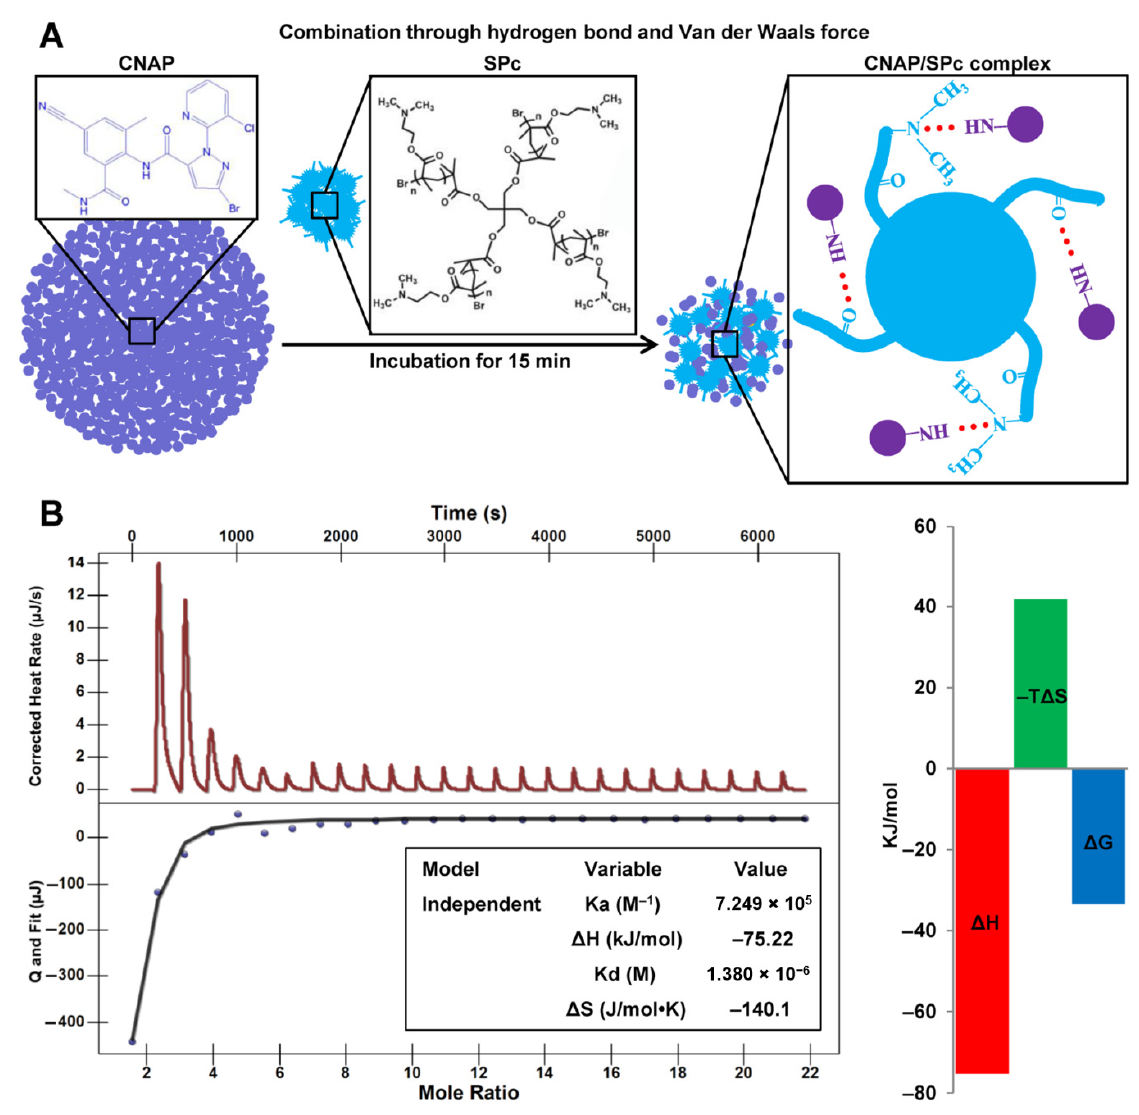
Figure 2. Schematic illustration of CNAP/SPc complex ( A ) and ITC titration of SPc (1 mM) into CNAP solution (0.0138 mM) ( B ). Table 2. Reduced particle size of SPc-loaded